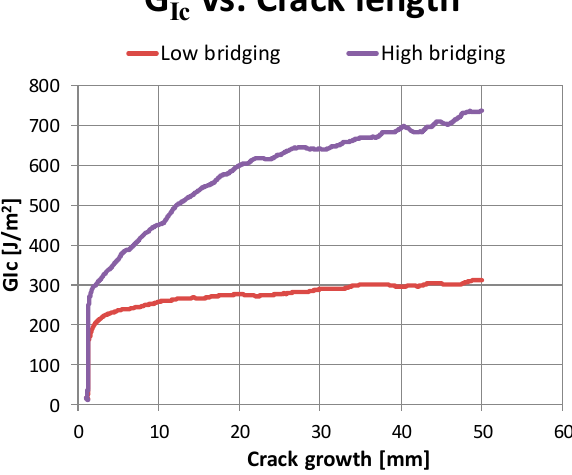
Figure 2. E ff ects of fiber bridging on G Ic vs. Crack length Figure 2. Effects of fiber bridging on G Ic vs. Crack length curves.